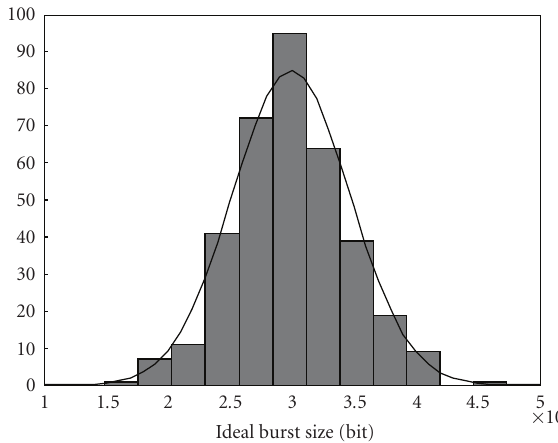
Figure 2: Histogram of ideal burst